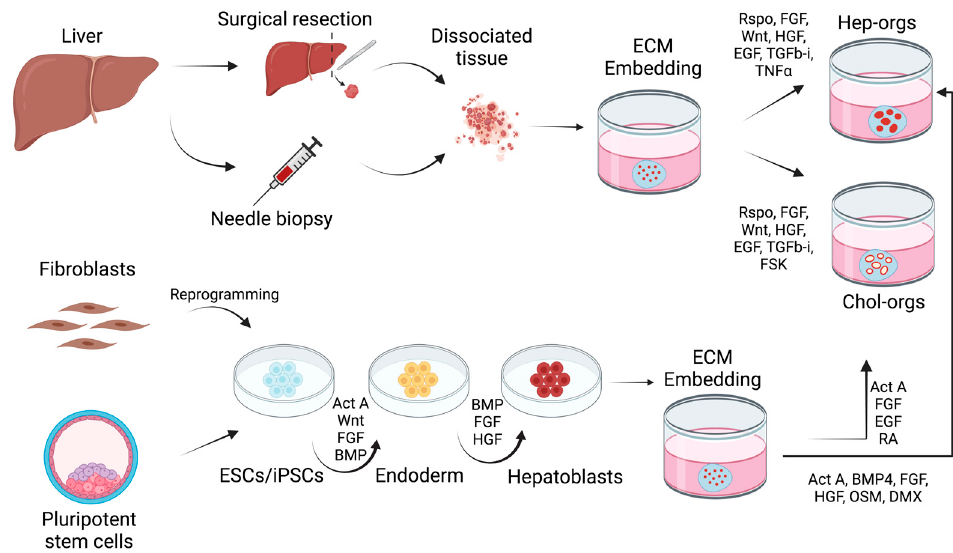
Figure 1. Schematic representation of the generation of liver organoids. Liver organoids can be derived from different sources. Tissue resident cells derived from surgical resection and needle biopsies of patients can be stimulated to form hep-orgs and chol-orgs following incubation with a defined cocktail of growth factors supplemented in medium. PSCs and iPSCs require a 3-stage differentiation protocol to generate hepatoblasts that are subsequently embedded in ECM (Matrigel or defined proteins) to promote organoids formation. Signaling pathways modulated to enhance the generation of organoids are indicated. Act A, activin A; BMP4, bone morphogenetic protein 4; DMX, dexamethasone; ECM, extracellular matrix; EGF, epidermal growth factor; ESCs, embryonic stem cells; FGF, fibroblast growth factor; FSK, forskolin; HGF, hepatocyte growth factor; iPSCs, induced pluripotent stem cells; OSM, oncostatin M; RA, retinoic acid; Rspo, R-Spondin; TGFb-I, transforming growth factor beta inhibitor; TNF α , tumor necrosis factor alpha.